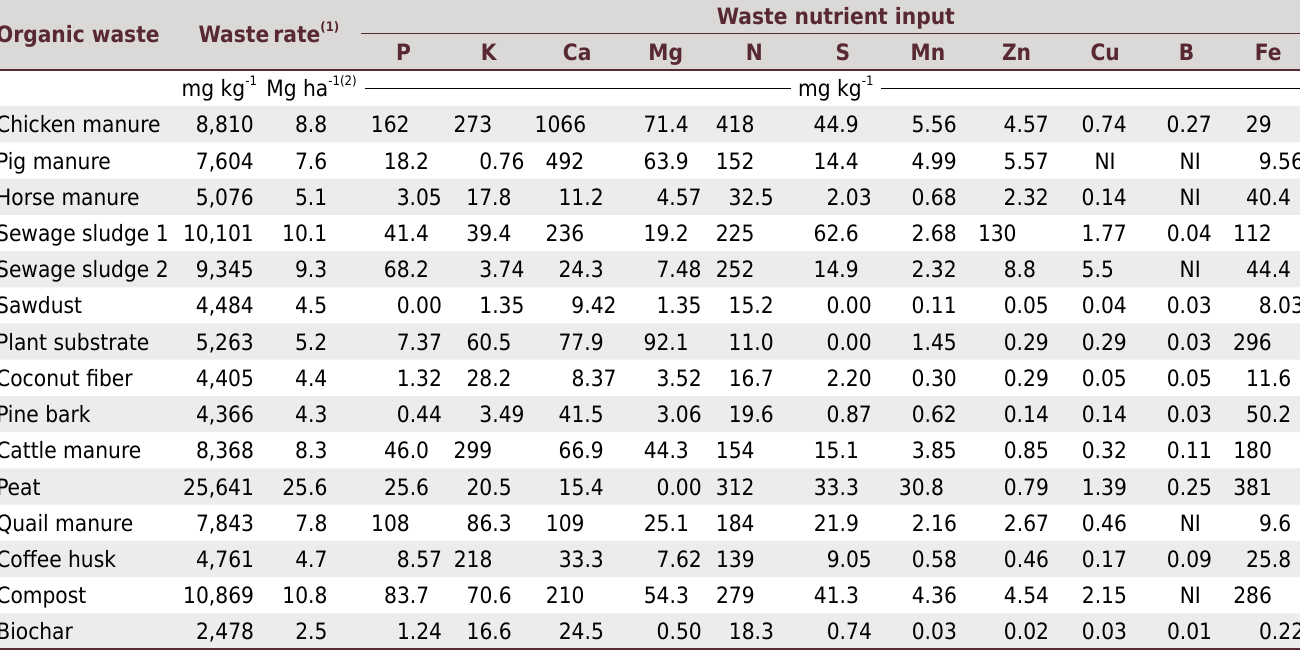
Table 3. Rates and nutrient inputs added for each of the organic